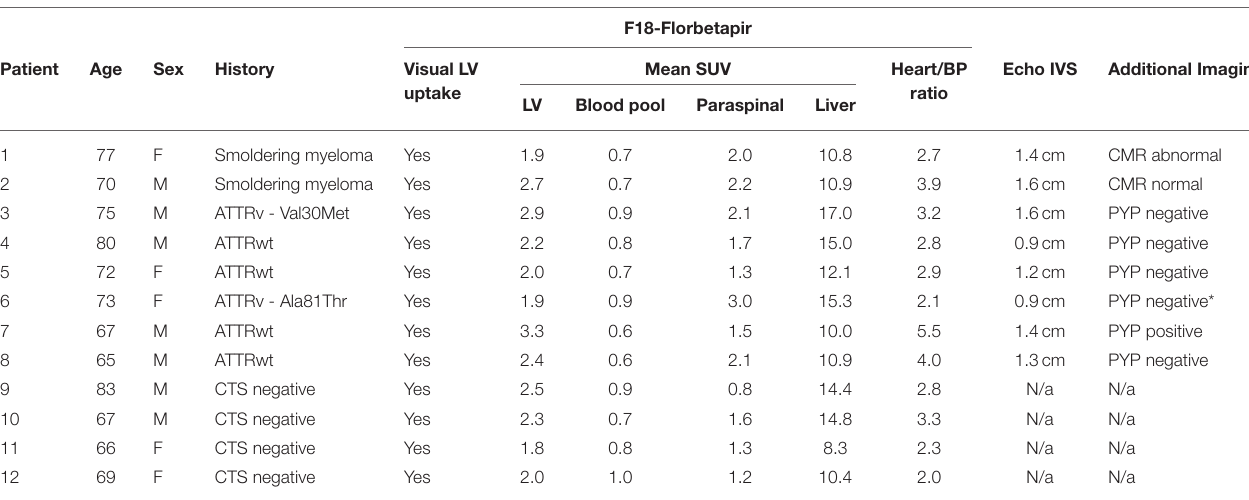
TABLE 1 | Summary of patients and imaging results.